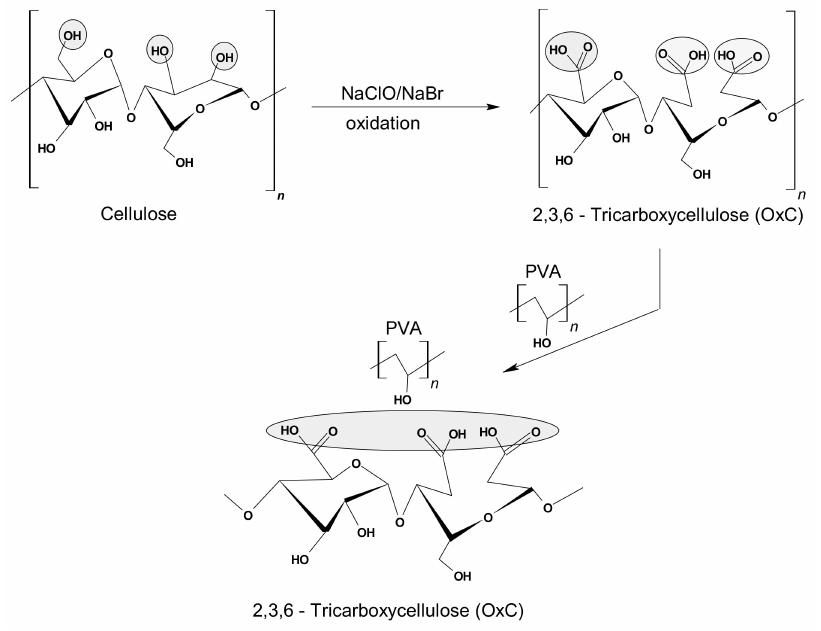
Figure 1. General synthesis scheme of the hybrid hydrogel based on PVA and 2,3,6-